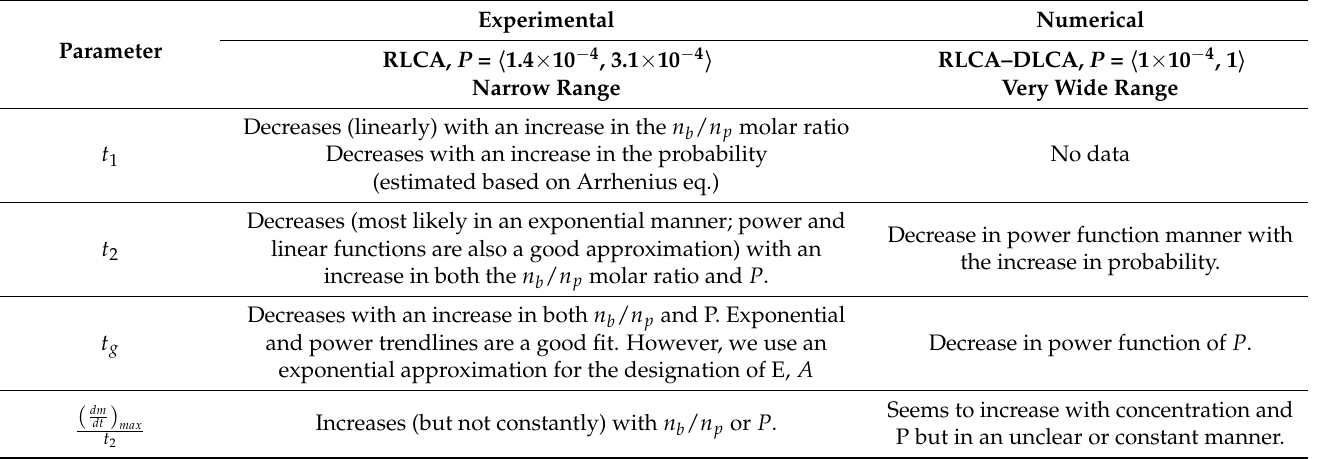
Table 5. Similarities and discrepancies between tendencies observed for experimental and numerical